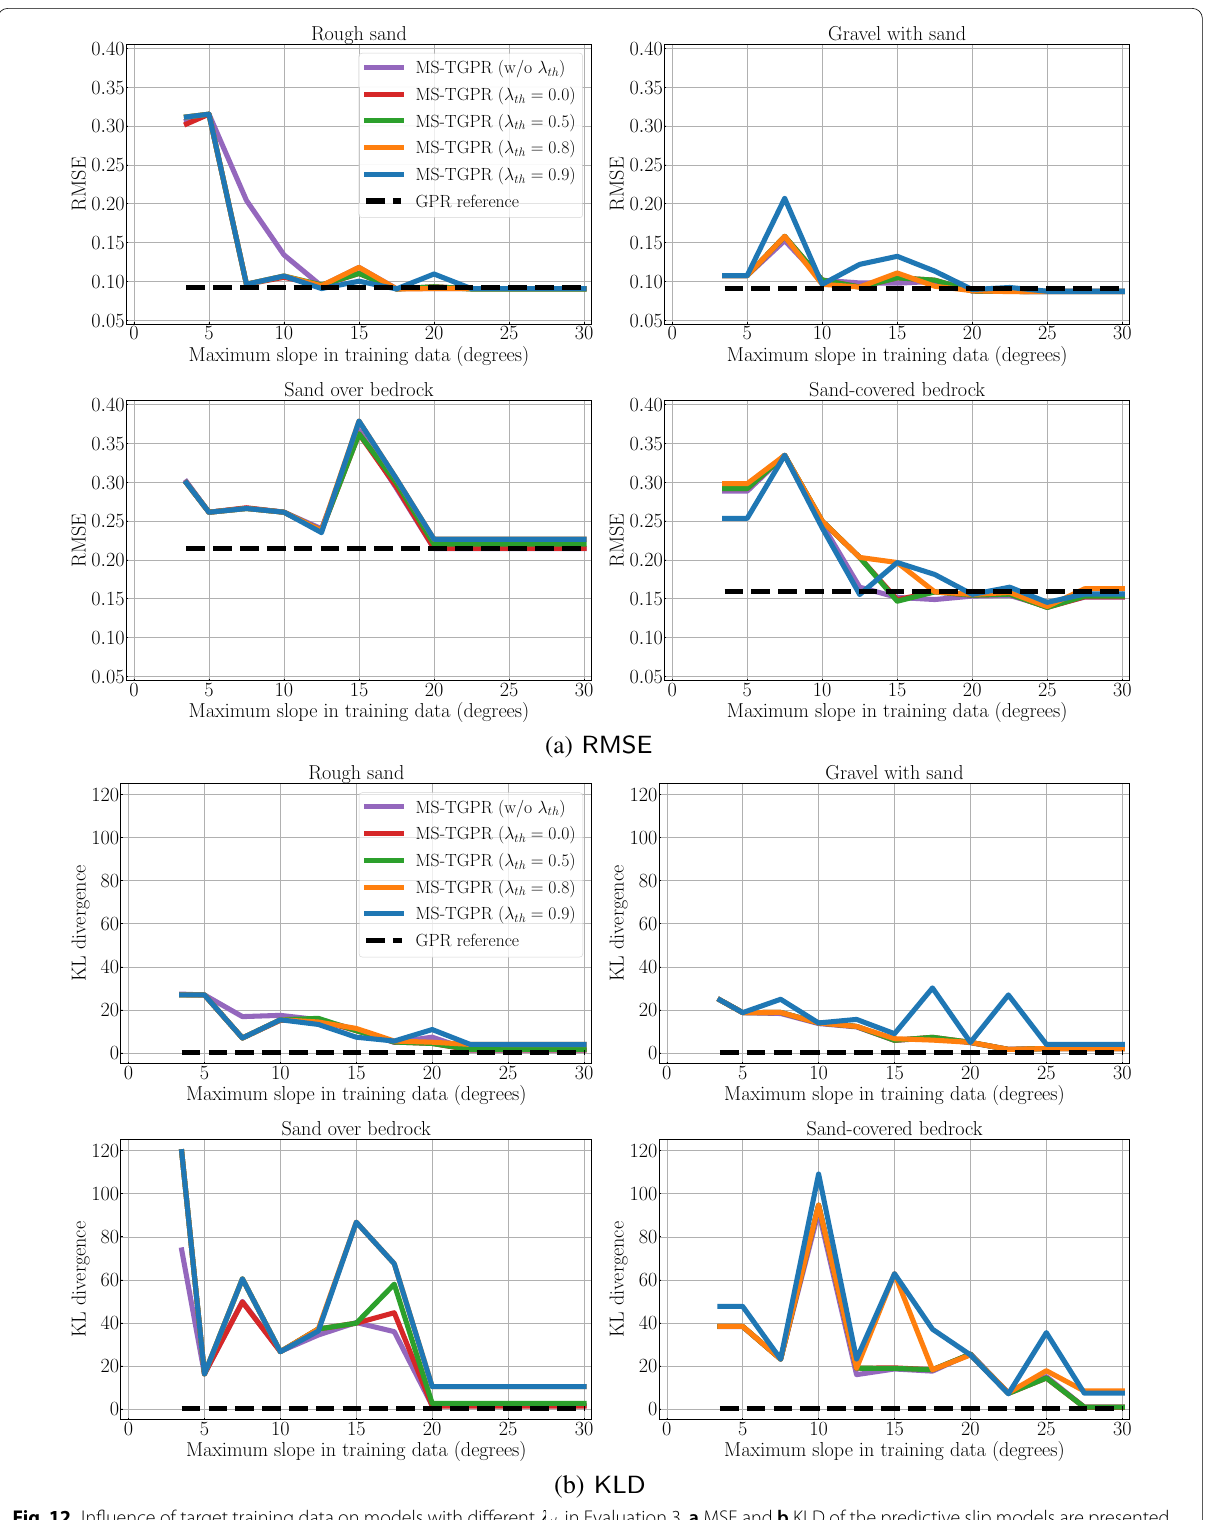
Fig. 12 Influence of target training data on models with different (cid:31) th in Evaluation 3. a MSE and b KLD of the predictive slip models are presented for various domain similarity threshold values (cid:31) th . The results for the four target domains are shown. (cid:31) th = 0.5 (green) shows a relatively stable performance for varied training